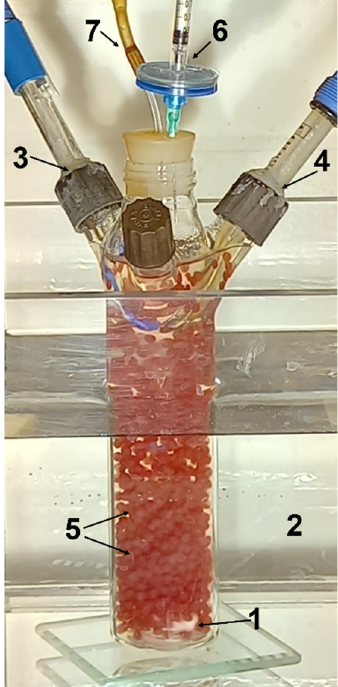
Figure 3. Picture of the cylindrical photobioreactor (0.22 L working volume). (1) Magnet; (2) water bath; (3) pH sensor; (4) redox sensor; (5) calcium alginate beads; (6) HCl sterile solution inlet; (7) H 2 exit.